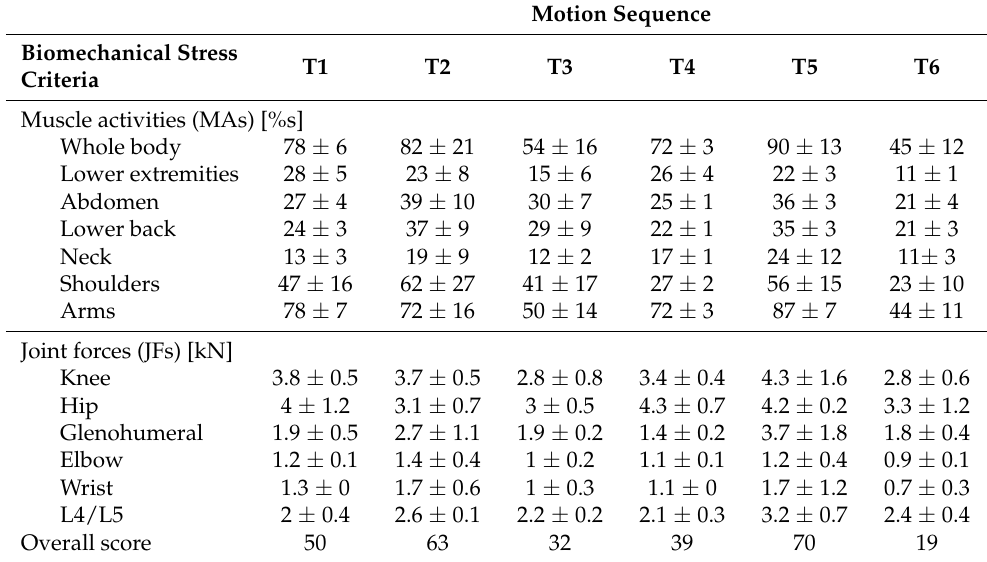
Table 1. Mean values and standard deviations of selected muscle activities (MAs) integrals over time and maximum joint forces (JFs) for six motion sequences over three subjects (L4/L5 shows the magnitude of the compression force between lumbar vertebrae L4 and L5; the other forces are magnitudes of resultant JFs of left and right side). The last row shows the overall score for each of the motion sequences (higher values depict higher overall stress). Note that some previously reported values [47] are included in column T5 for better